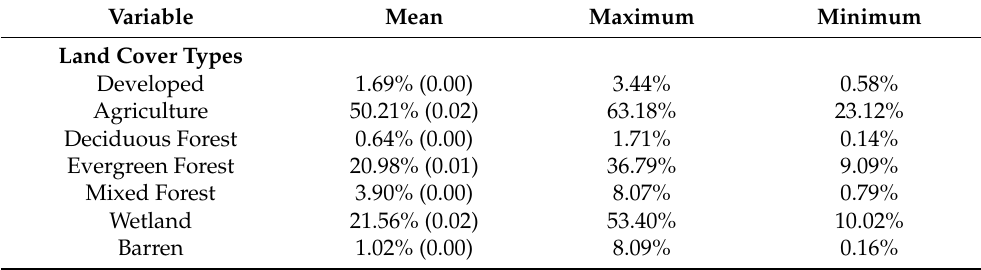
Table 4. Maximum, minimum, and means (standard error; SE) percent land cover above each mussel sampling site in Pearl River tributary streams sampled in 2015 and